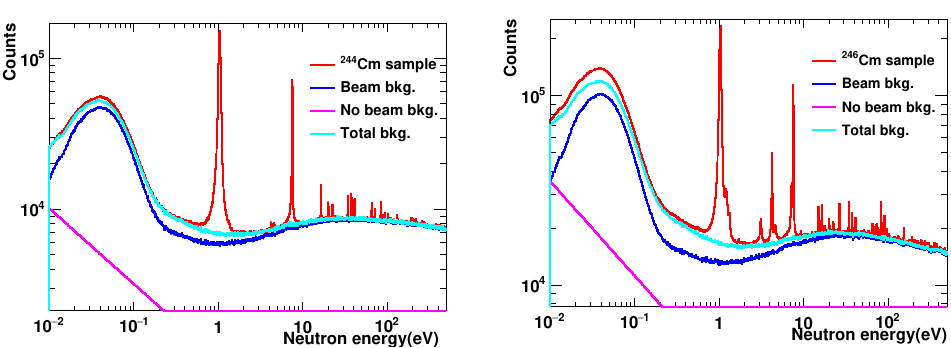
Figure 2. Total number of counts (750 bins per decade) and estimated backgrounds registered in the 244 Cm (left) and 246 Cm (right) EAR-2